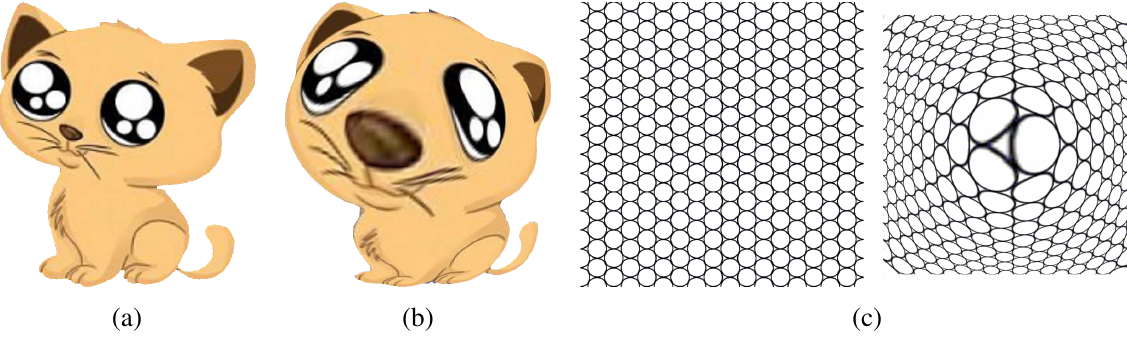
Figure 1. A diffeomorphism of an image caused by a quasiconformal mapping. The distortion of circles demonstrates the diffeomorphism of the original image. ( a ) Original image; ( b ) deformed image; ( c ) quasiconformal